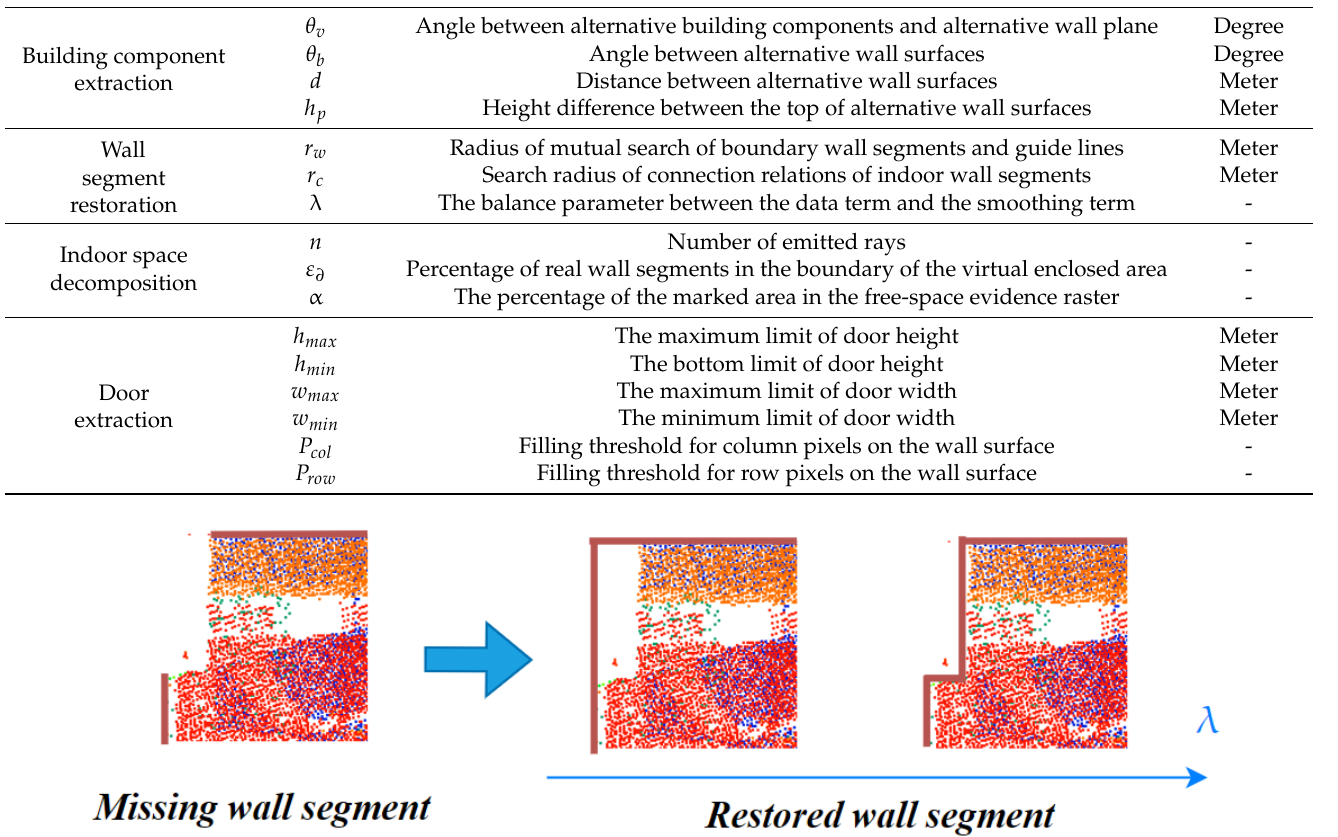
Figure 13. The effect of the change in λ on wall restoration.